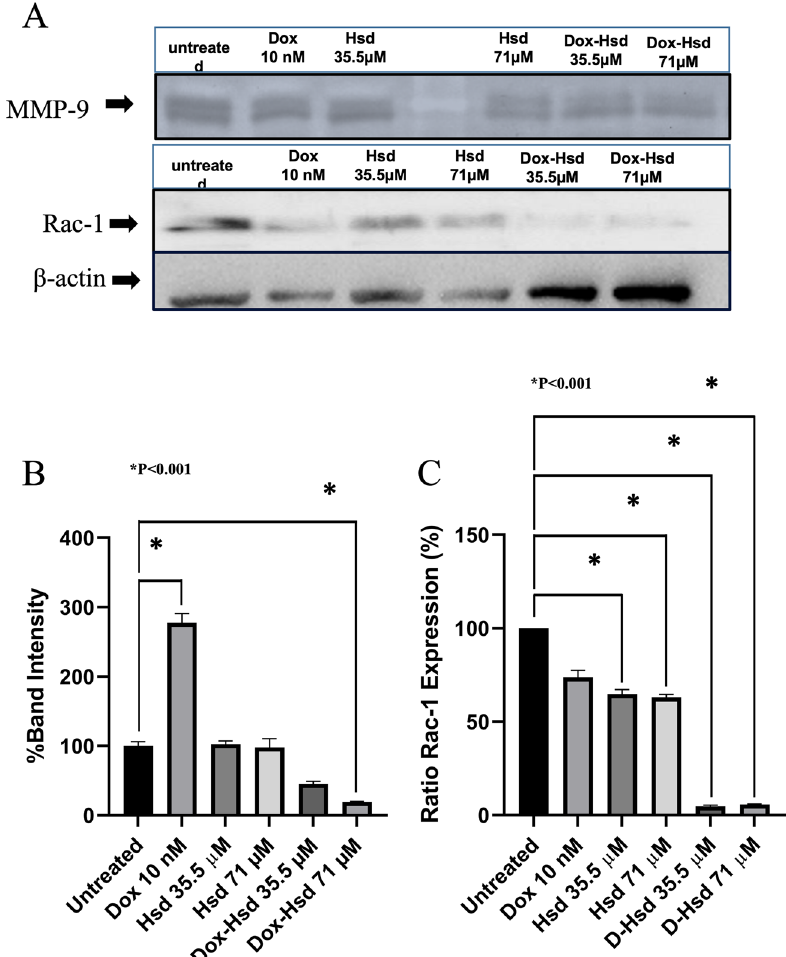
Fig. 4 The activity of MMP-9 and the expression of Rac-1 after Hsd, DOX, and combination treatments on 4T1 breast cancer cells. The 4T1 cells were incubated with test samples for 24 h for further isolation and assays. A The MMP activity of MMP 9 and pro MMP 9 were analyzed using gelatin zymography. B The quantification of MMP 9 expression levels under gelatine zymography. C Rac-1 expression level of cell migration-related proteins was measured by western blotting. The quantification of band intensity was calculated with ImageJ software and presented as the graph ratio compared with untreated. The data were shown as the mean SD of a triplicate independent experiment. * p < 0.001 (post-hoc LSD test ± between each group) was considered statistically